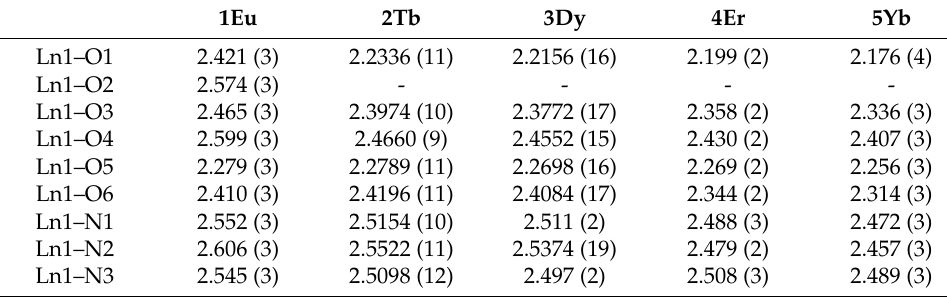
Table 2. Selected bond distances (Å) for 1Eu – 5Yb